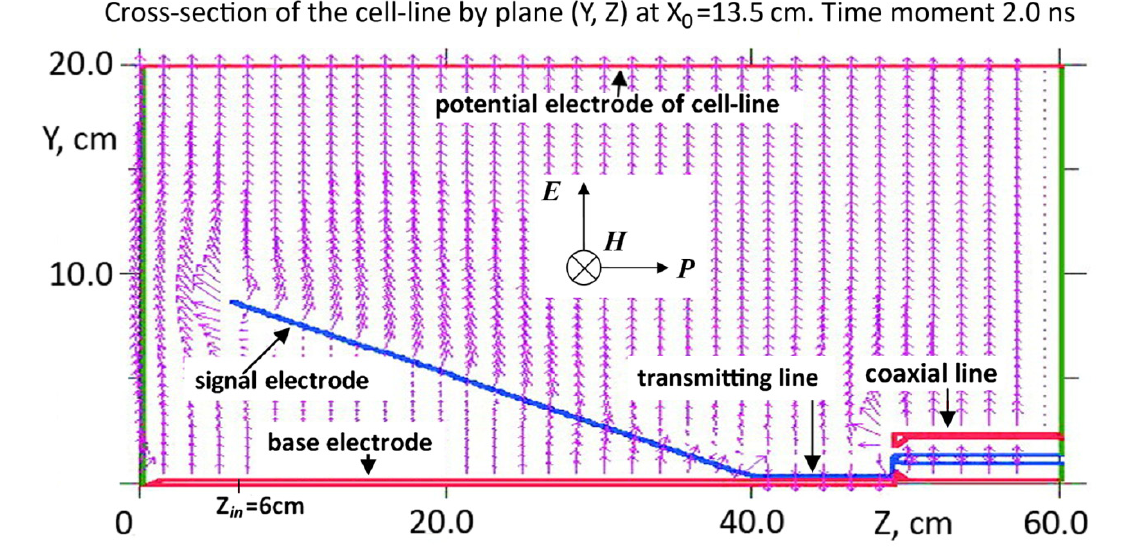
Figure 2. Line schematics of the TEM half-horn antenna 1, with the ( Y , Z )-planes on x 0 = 13.5 cm in the middle of the cell line and drawings of E -field vectors of the external EM wave.